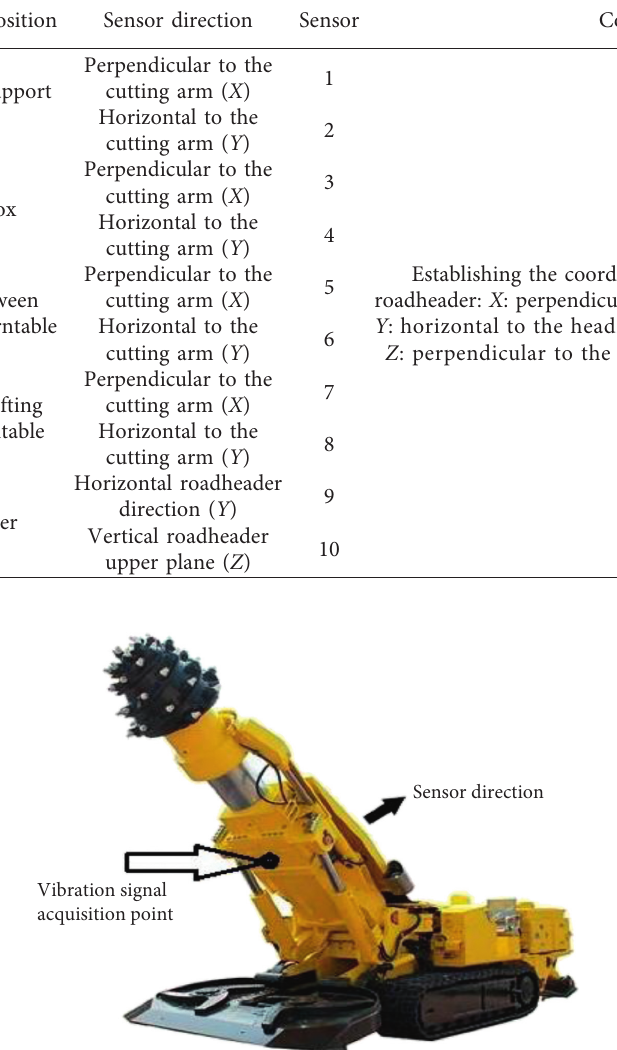
Figure 7: Arrangement drawing of vibrating